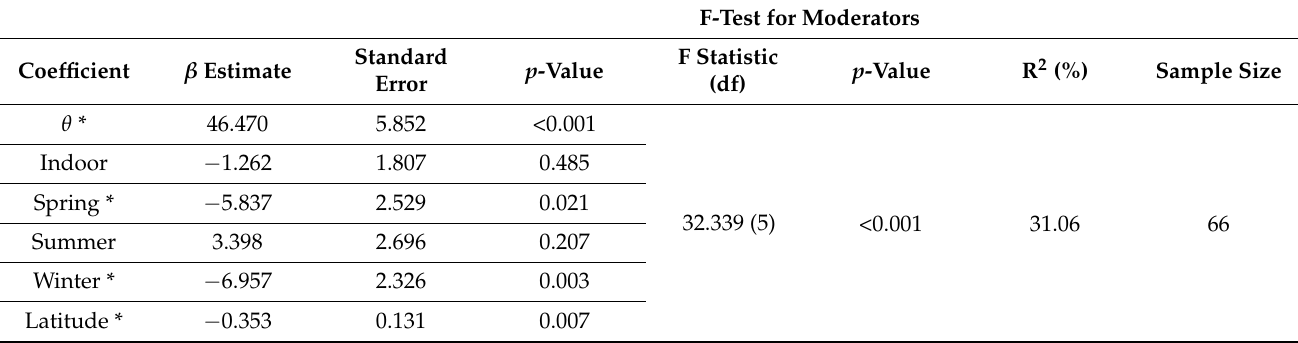
Table 4. Multivariate model investigating the significance of the type of sport, season, and latitude as predictors of vitamin D levels. * = predictors with significant ( p < 0.05) β -coefficient. F-Test for